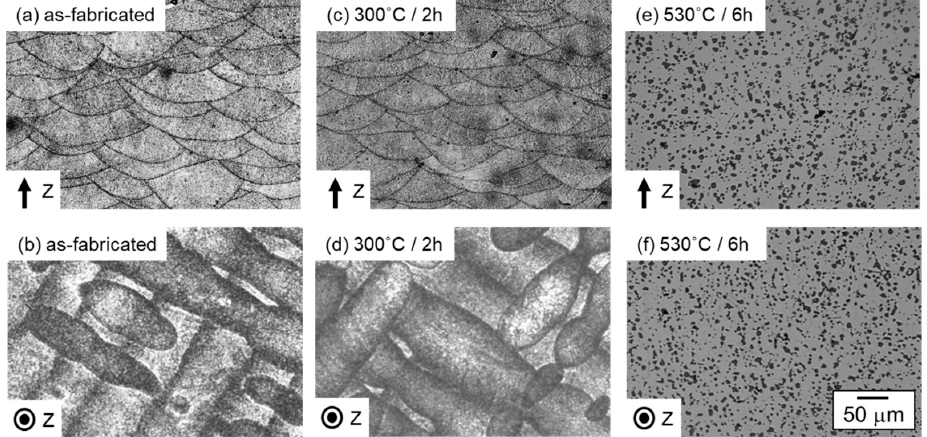
Figure 3. Optical micrographs showing microstructures of ( a , b ) as-fabricated, ( c , d ) 300 °C/2 h annealed and ( e , f ) 530 °C/6 h annealed samples observed from the sections ( a , c , e ) parallel and ( b , d , f ) normal to the building direction (z axis).